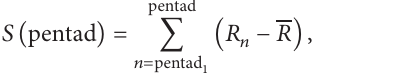
the large amount of rainfall during summer, the monsoon period is also characterized by the intensification of the low levels northeasterly trade winds flowing from the North Atlantic Ocean to the continent, by the development at 200 hPa of an anticyclonic system over Bolivia (Bolivia High) and a downstream trough located near the northeastern Brazil